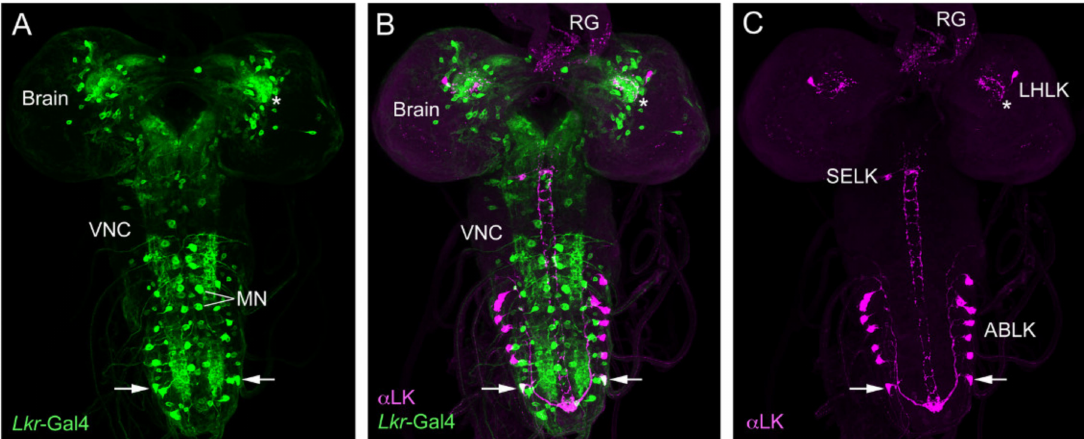
Figure 5. Expression of LK immunolabeling and Lkr -Gal4 in the larval CNS. ( A ) Lkr -Gal4 is seen in numerous neurons throughout the CNS. Some are large segmental motoneurons (MN) of the abdominal neuromeres known to innervate body wall muscle (either aCC or RP2 motoneurons). VNC, ventral nerve cord. ( B ) LK immunolabeling and Lkr -Gal4 reveals that one pair of ABLKs display Lkr -Gal4 expression (arrows). Note the strong expression of Lkr in the lateral horn (asterisk) where LHLKs arborize. ( C ) LK immunolabeled neurons. The axon terminations in the ring gland (RG) are from ALK neurons (their cell bodies are not seen in this focal plane). Figure reproduced from [38] with permission from the publisher.